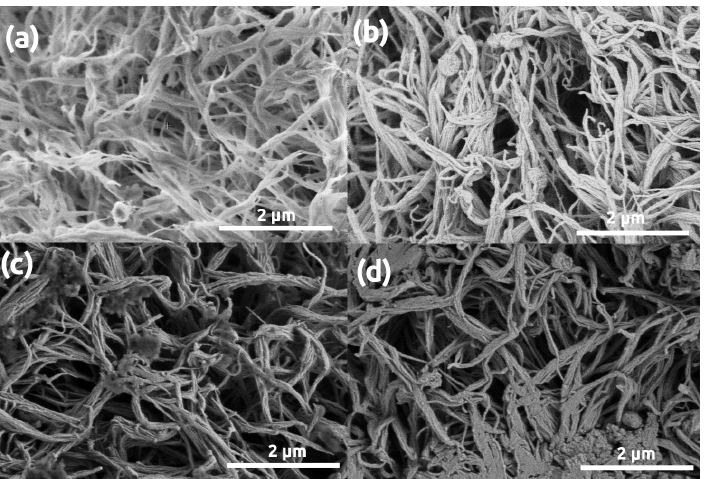
Figure 7. LVSEM images of polyamide-Ca(II) aerogel samples. ( a ) Pristine, uncoated. ( b – d ) Sputter coated with 5 nm, 16 nm, 32 nm thick Au layers,